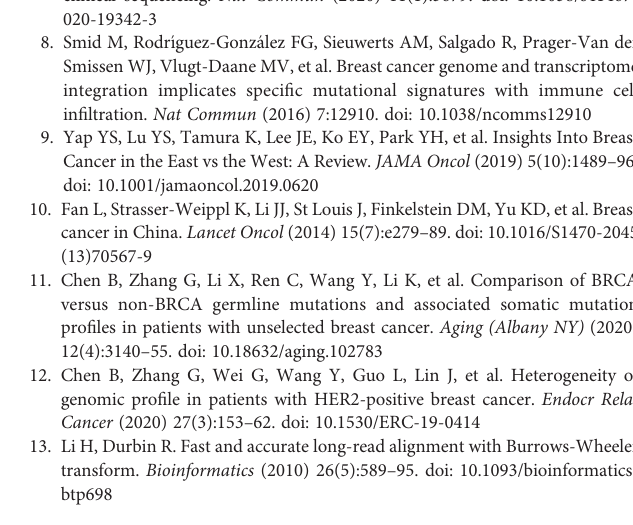
Supplementary Table 2 | The clinical and pathological characteristics of the 589 patients in our cohort (GDPH). Supplementary Figure 1 | Comparison of somatic genomic alterations in younger( ≤ 35years)patientswithbreastcancerinourcohort(GDPH)andtheTCGA cohort. Different colors indicate different types of mutations and different clinicopathological features. Indel, insertion/deletion mutation; CN_amp, copy number ampli fi cation; CN_del, copy number deletion. Supplementary Figure 2 | Comparison of somatic genomic alterations in triple- negative breast cancer between Chinese patients (GDPH cohort) and the TCGA cohort. Different colors indicate different types of mutations and different clinicopathological features. Indel, insertion/deletion mutation; CN_amp, copy number ampli fi cation; CN_del, copy number deletion. Supplementary Figure 3 | Comparison of somatic genomic alterations of invasive lobular breast cancer (ILBC) between Chinese patients (GDPH cohort) and the TCGA cohort. Different colors indicate different types of mutations and different clinicopathological features. Indel, insertion/deletion mutation; CN_amp, copy number ampli fi cation; CN_del, copy number